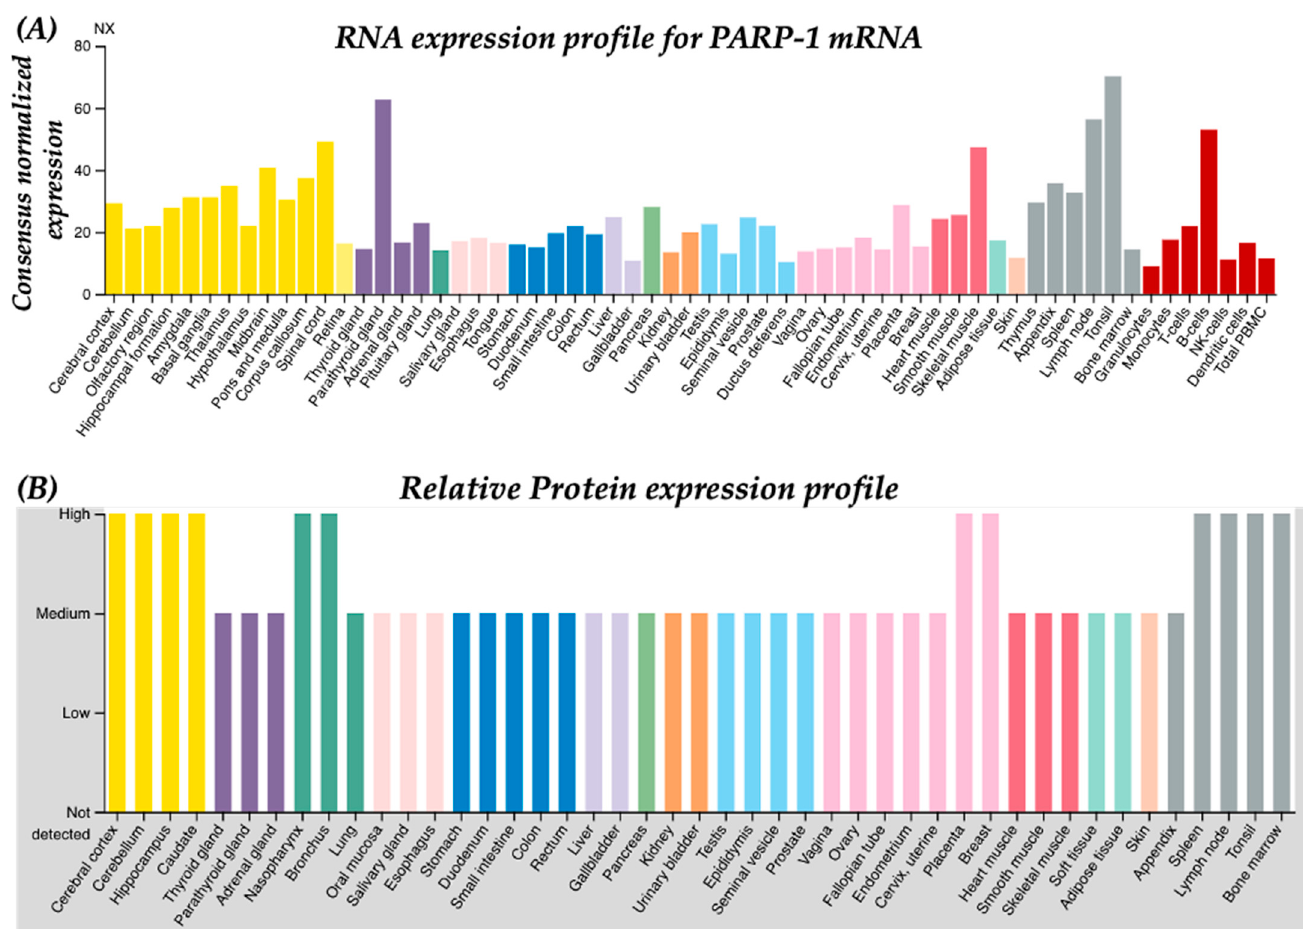
Figure 3. PARP-1 is expressed in all tissue types. ( A ) Normalized RNA expression profile for PARP-1 mRNA across human tissues. ( B ) Relative protein expression profile for PARP-1 across human tissues. These figures are obtained from the publicly available human protein and cell type atlas at proteinatlas.org. Details of data analysis, annotation, and normalization can be obtained at https://www.proteinatlas.org/ENSG00000143799-PARP1/tissue (accessed on 17 September 2021).